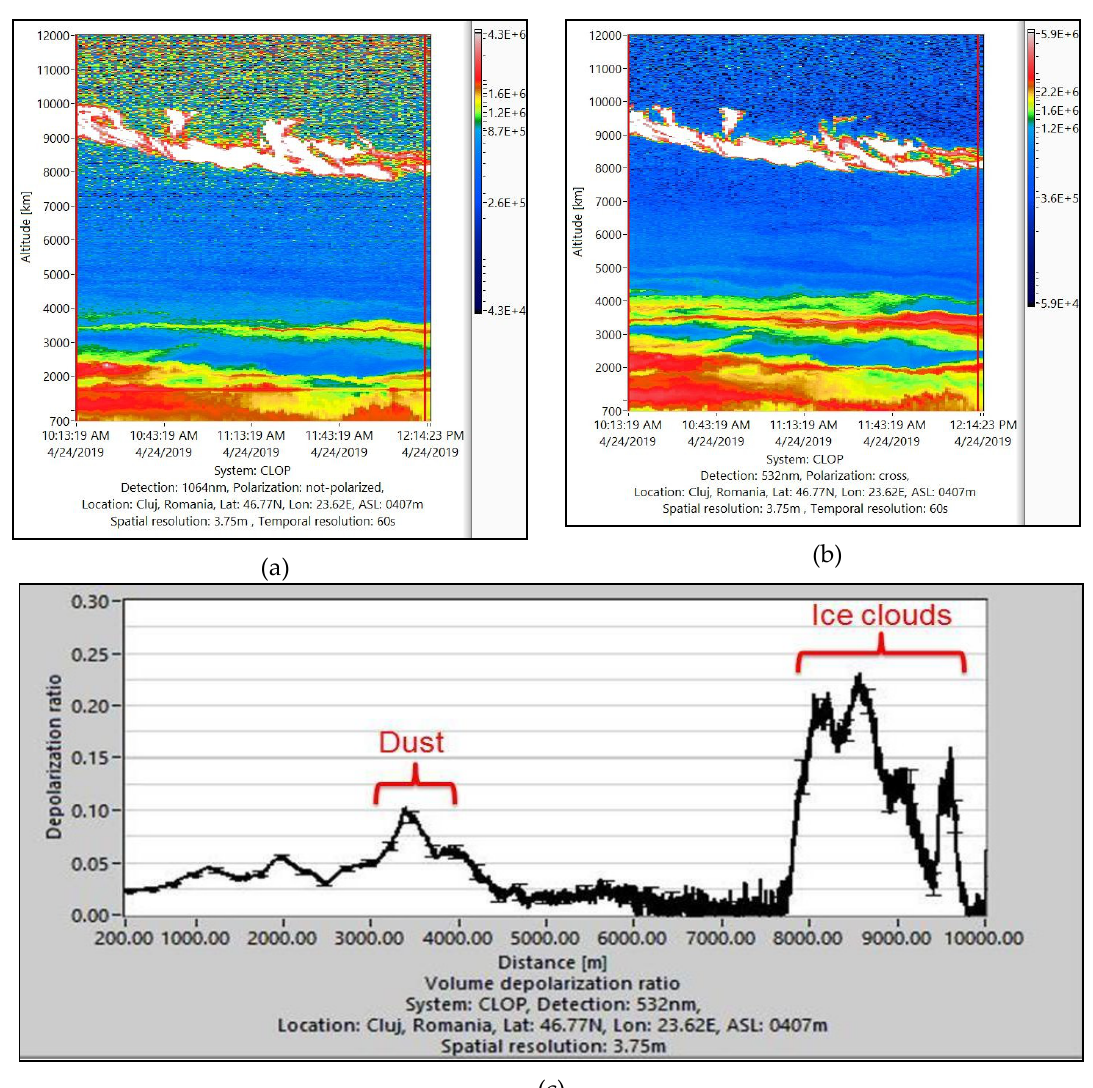
Figure 2. Cluj‐Napoca lidar system (CLOP) lidar RCS for 24.04.2019: 10:15–12:15 UTC,